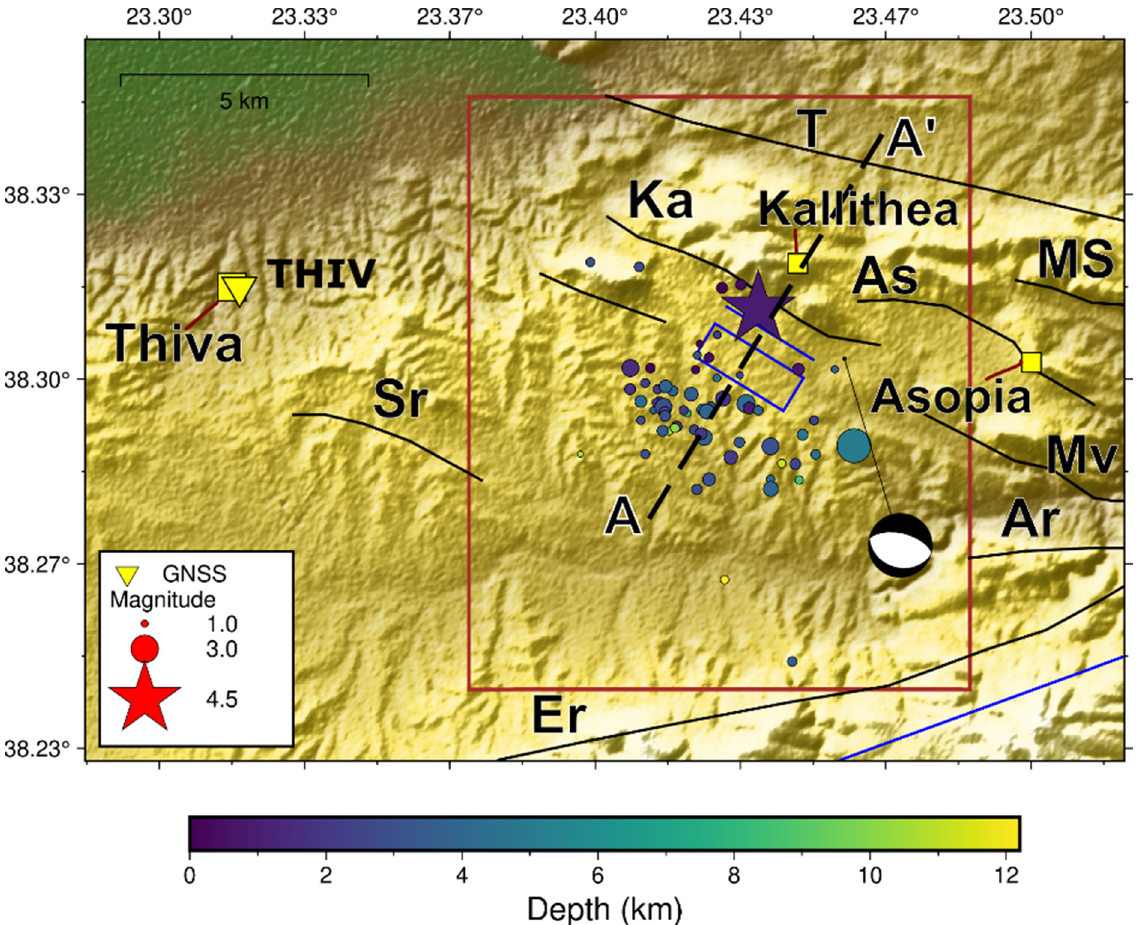
Figure 5. Seismotectonic map, showcasing the obtained location results for the mainshock (star) and the epicenters of the aftershock sequence (circles), colored after the focal depth (see color bar). We also present the centroid’s surface projection and the determined focal mechanism (beachball), along with the InSAR-inferred rupture area (brown rectangle) and its projected intersection with the surface (brown line). The city of Thiva (square), where the GNSS station THIV (inverted triangle) is installed, is located to the west of the sequence. The villages of Kallithea and Asopia (squares) are located on nearby faults. Faults (black lines) after [8,9]; Sr: Soros, T: Thiva, Ka: Kallithea, As: Asopia, Mv: Mavrovouni, Ar: Asopos river, MS: Megalos Schinos and Er: Erythres. The boundary between the two blocks proposed in [7] is in the SE corner of the area (blue line). Cross-section (dashed line A–A’) is presented in Figure 7. The blue rectangle shows the area of Figures 6 and A4.